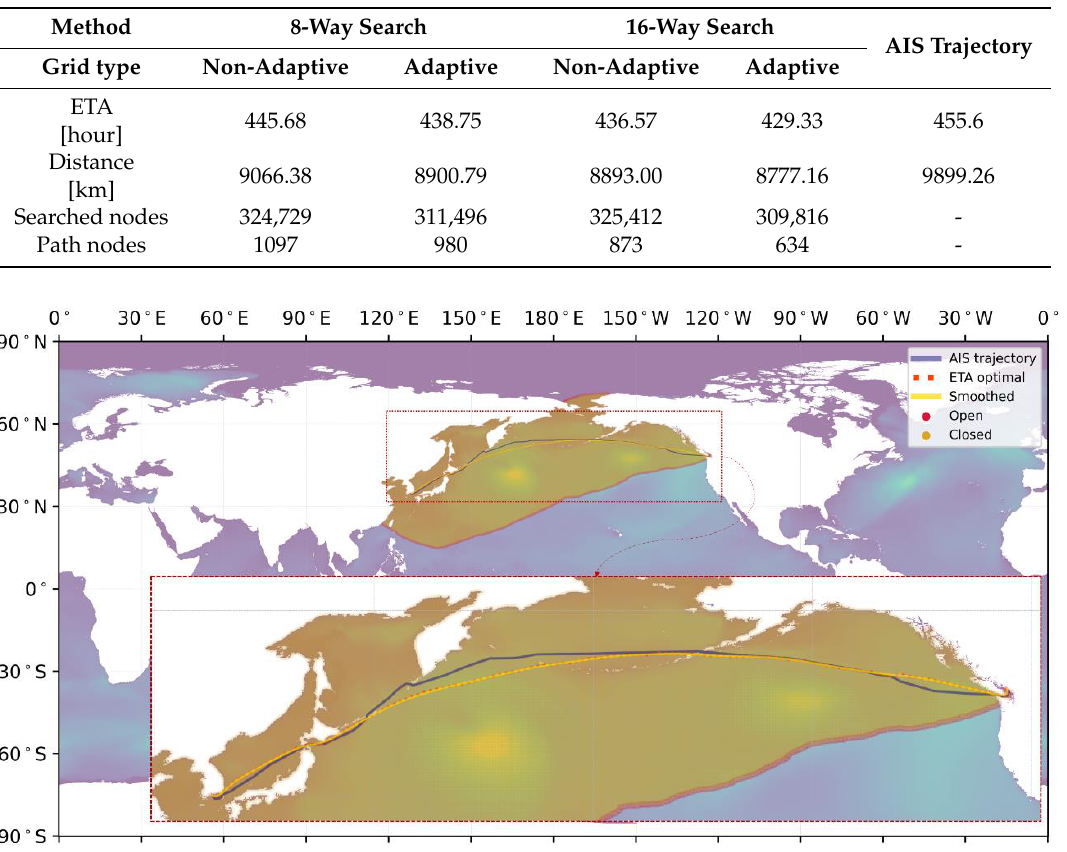
Figure 9. Result of 16-way search with adaptive grid.